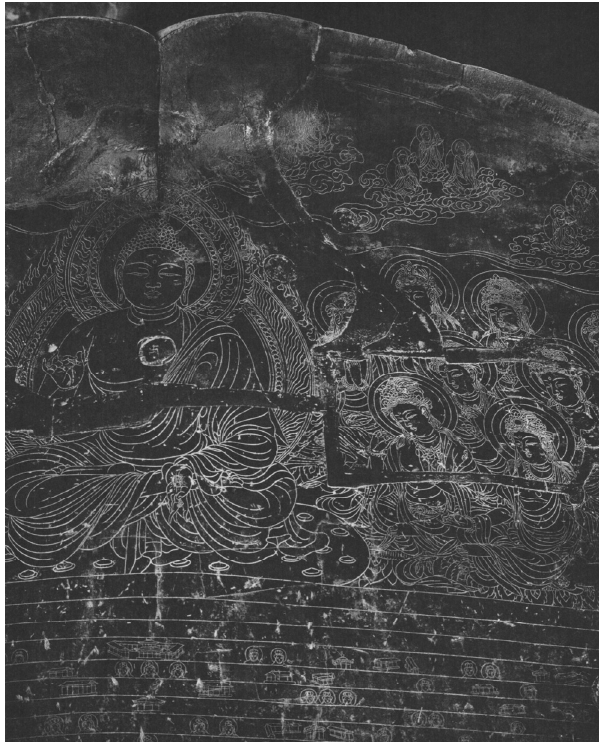
Figure 6. Śākyamuni Buddha and twenty‑two bodhisattva attendants. Line carving on the bronze pedestal (detail). Seated Vairocana Buddha. Reproduced from Nara Rokudaiji Taikan Kankōkai (2001), p. 167.